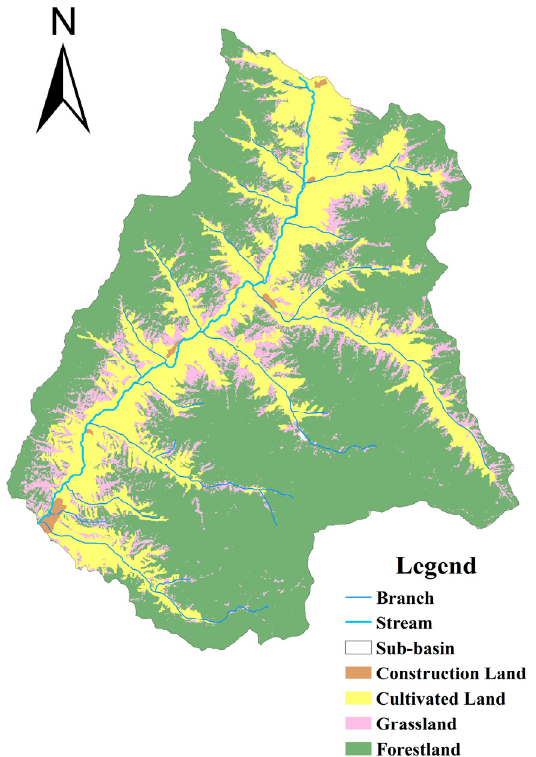
Figure 2. The land use types in Gedong basin.